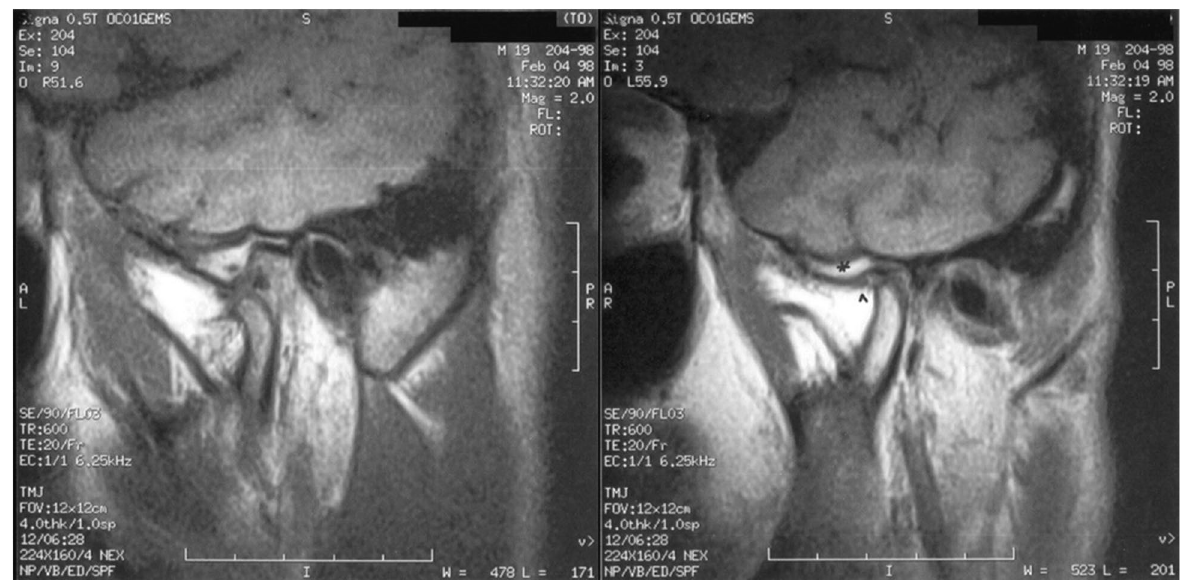
Fig. 3 Magnetic resonance imaging (MRI) sagittal T1 weighted scans. a right temporomandibular joint (TMJ), open mouth: physiologic joint with normal condylar excursion. b left TMJ, open mouth: notice a less pronounced anterior tubercle of the temporal bone and a shallow articular cavity